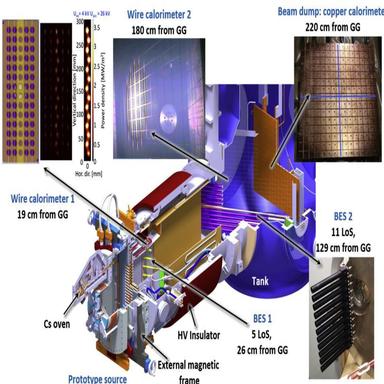
The BATMAN Upgrade test facility with the beam diagnostic tools and their position relative to the last grid of the extraction system, the grounded grid (GG).